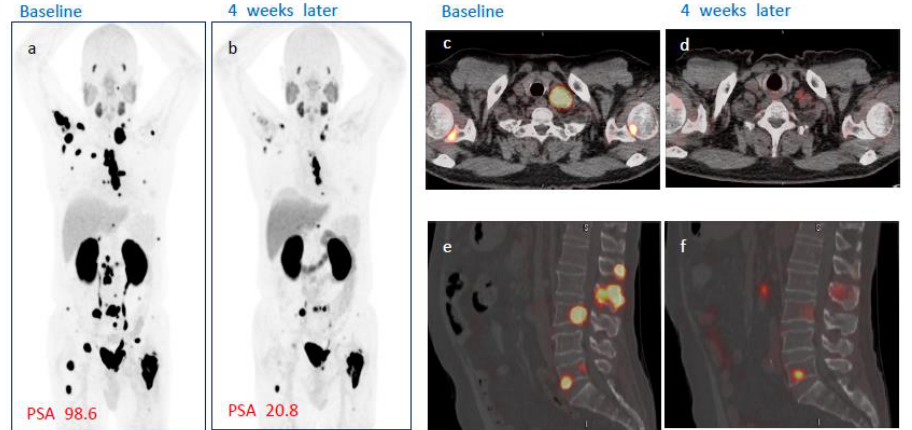
Figure 4. A case of a subject showing response to [ 177 Lu]Ludotadipep . ( a , c , e ) Baseline [ 18 F]Florastamin PSMA PET/CT MIP, fused axial and sagittal images. ( b , d , e ) PSMA PET/CT images four weeks after administration of [ 177 Lu]Ludotadipeps ( a , b ) MIP images show decreased tumor burden in the bone lesions and lymph nodes. ( c , d ) Axial fused PSMA PET/CT images show marked regression of left supraclavicular lymph node and bone metastases. ( e , f ) Sagittal PSMA PET/CT images show decreased uptake in the spine lesions.